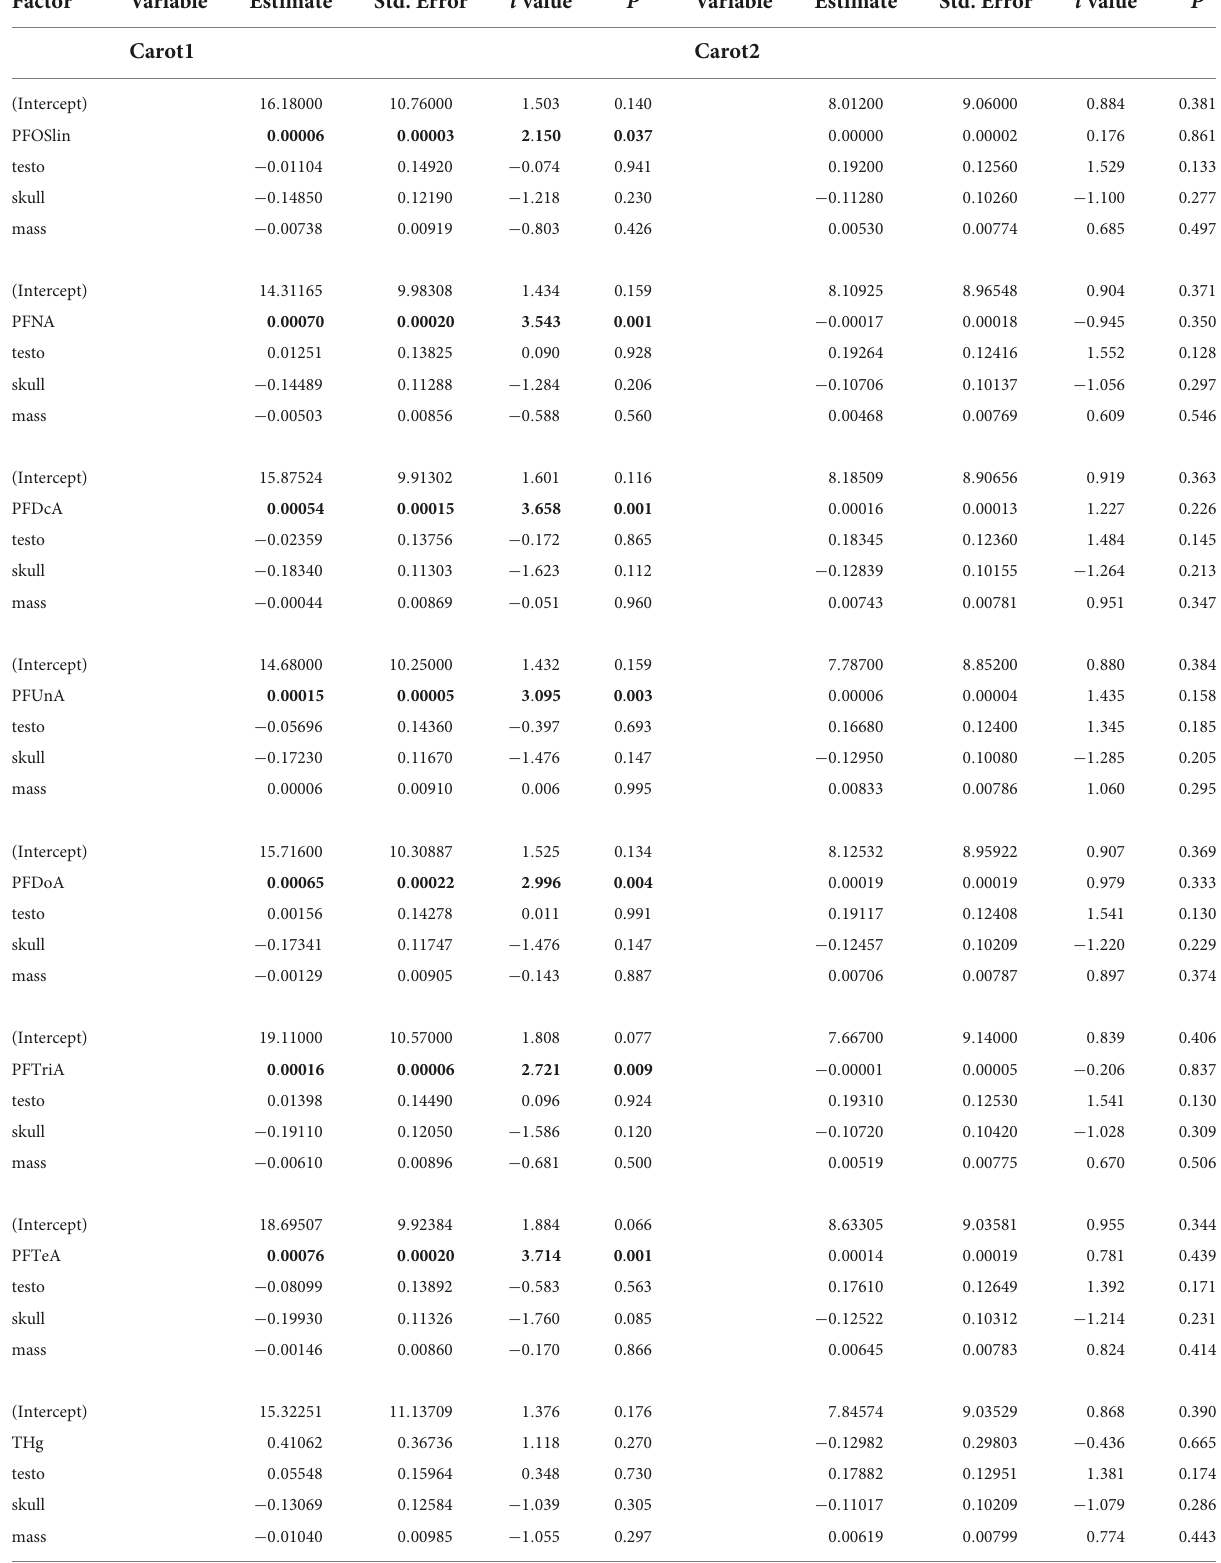
TABLE 3 Outcomes of lme models testing the effects of contaminants on the concentrations of carotenoids in plasma. Factor Variable